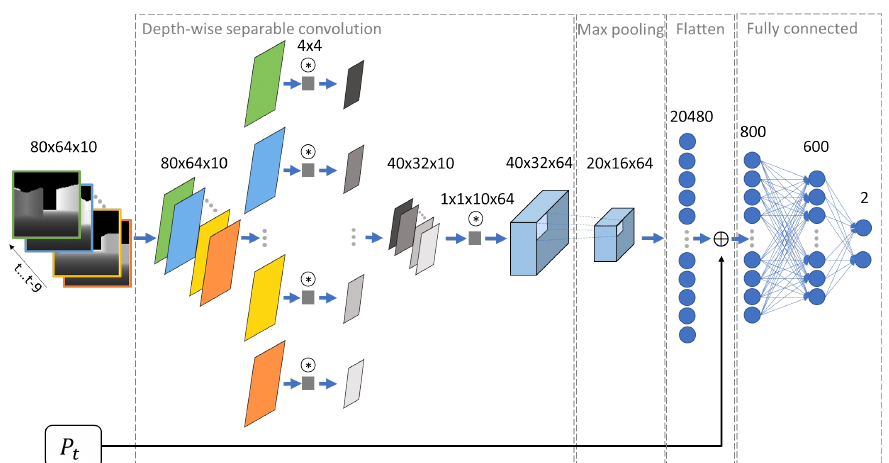
Figure 1. Architecture of the proposed actor network. Depth-wise separable convolution is performed on a stack of depth images. Max pooling is performed on the output. Positional information is concatenated with the depth information, followed by two fully connected layers and an output layer. (cid:126) and ⊕ denote convolution and concatenation,